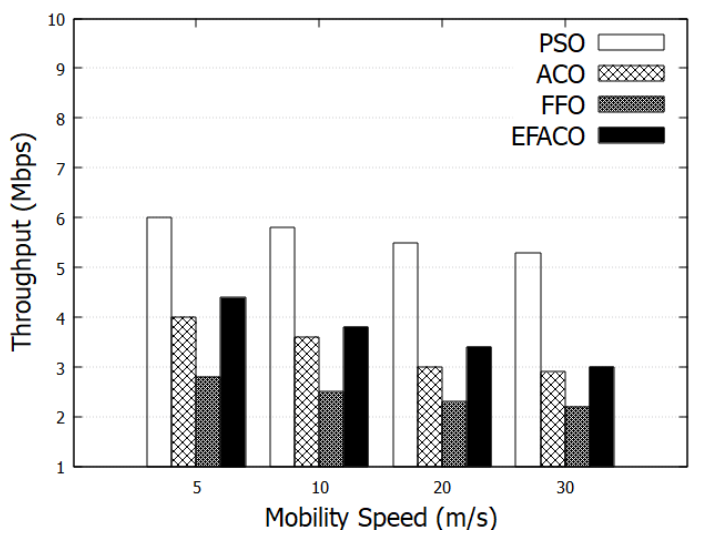
Figure 6. Comparison between proposed PSO, ACO, FFO, EFACO for throughput with mobil- ity speed. Table 2. Throughput vs. mobility speed in Figure